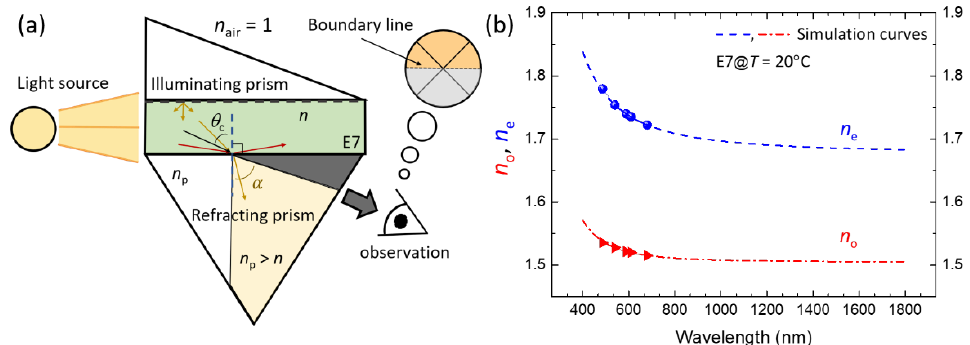
Figure 3. ( a ) Schematic of the working principle of the Abbe refractometer and ( b ) wavelength-dependent refractive indices of E7 at T = 20 °C. The symbol n p denotes the refractive index of the prism and θ c is the critical angle. The simulated curves extended to the NIR region are the dispersion functions obtained by fitting the experimental data at five visible wavelengths into the extended Cauchy equation [50].